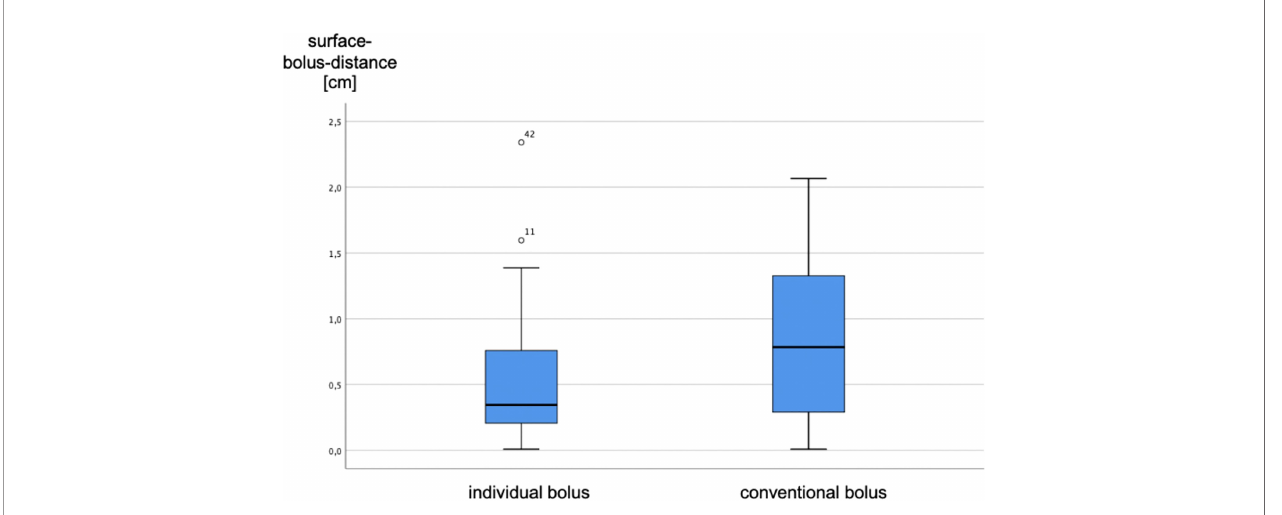
FIGURE 8 | Surface – bolus distances under conventional and individual